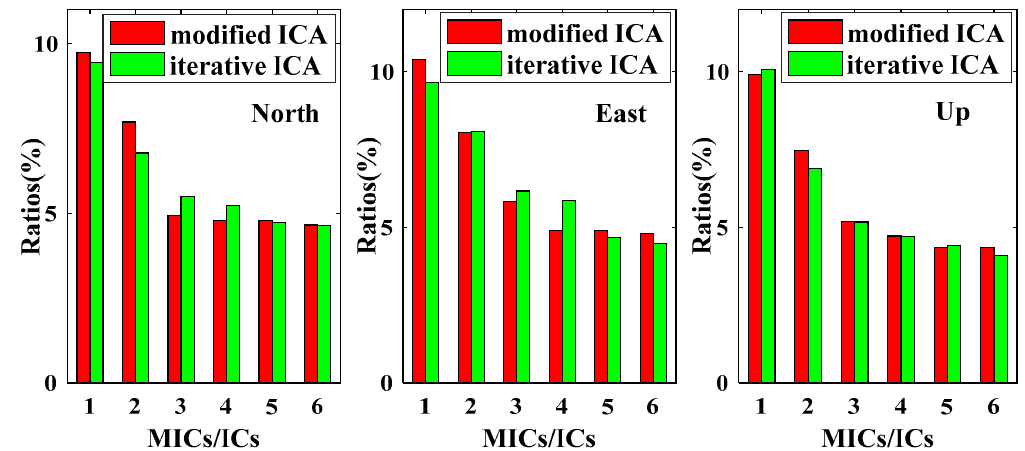
Figure 5. Contribution ratios of the first six modified independent component analysis (ICA)-derived independent components (MICs) and independent components (ICs).